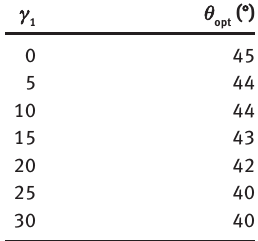
Table 4 Effect of unsymmetric trapezoidal laminated plates on the optimum fiber